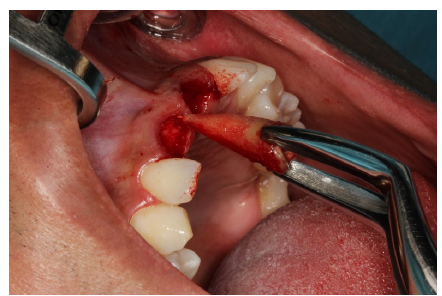
Figure 6. Atraumatic extraction of elements #11 and #21.